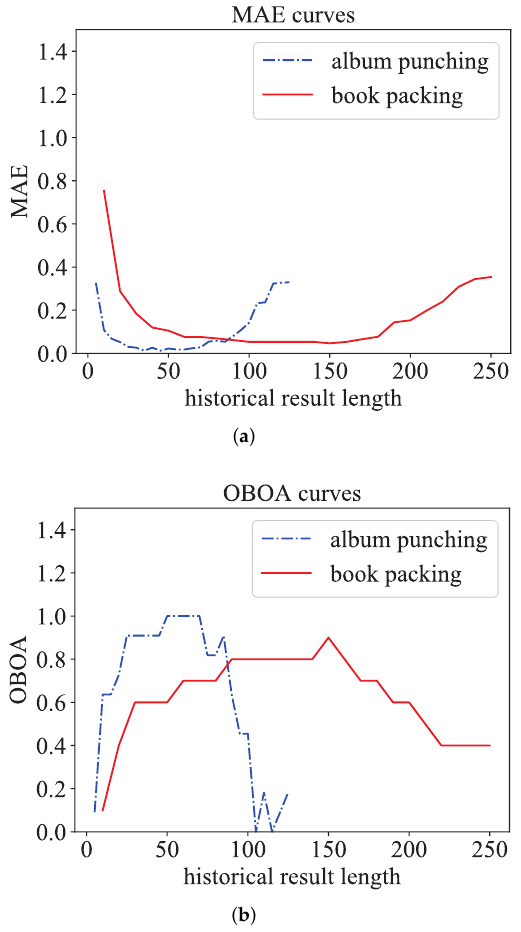
Figure 12. MAE and OBOA curves. ( a ) the curves of MAE, ( b ) the curves of